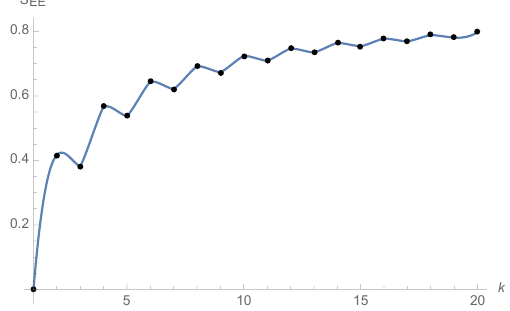
Figure 7 . (a) The two component link 4 2 N = 2. (b) One way to evaluate the corresponding link invariant for general N is to perform surgery along the dashed blue circle. The twisting of the link is accomplished by using a Dehn N as indicated. twist T